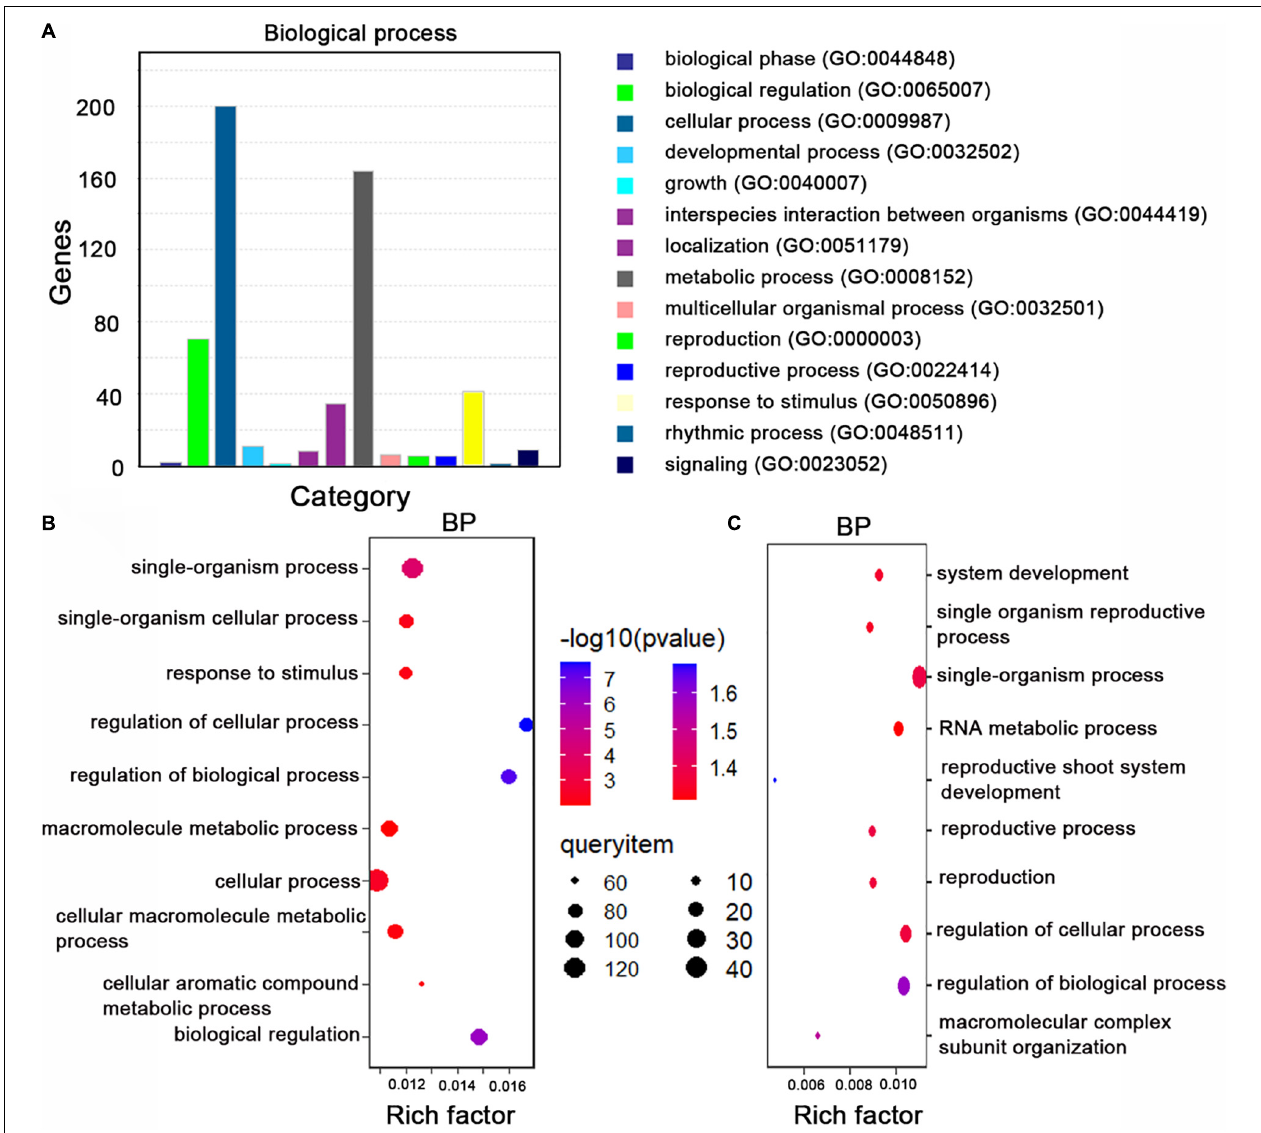
FIGURE 3 | Gene ontology (GO) analyze the miRNA target genes. (A) The top 14 GO terms (biological process category) among the miRNA target genes. The enriched processes are listed on the right. (B) The top 10 GO terms (biological process category) among the 328 variant miRNA target genes in B. napus . The enriched processes are listed on the left. (C) The top 10 GO terms (biological process category) among the 124 rare variant target genes in rapeseed. The enriched processes are listed on the right. Rich factor: number of candidate genes/total number of genes. BP: biological process.